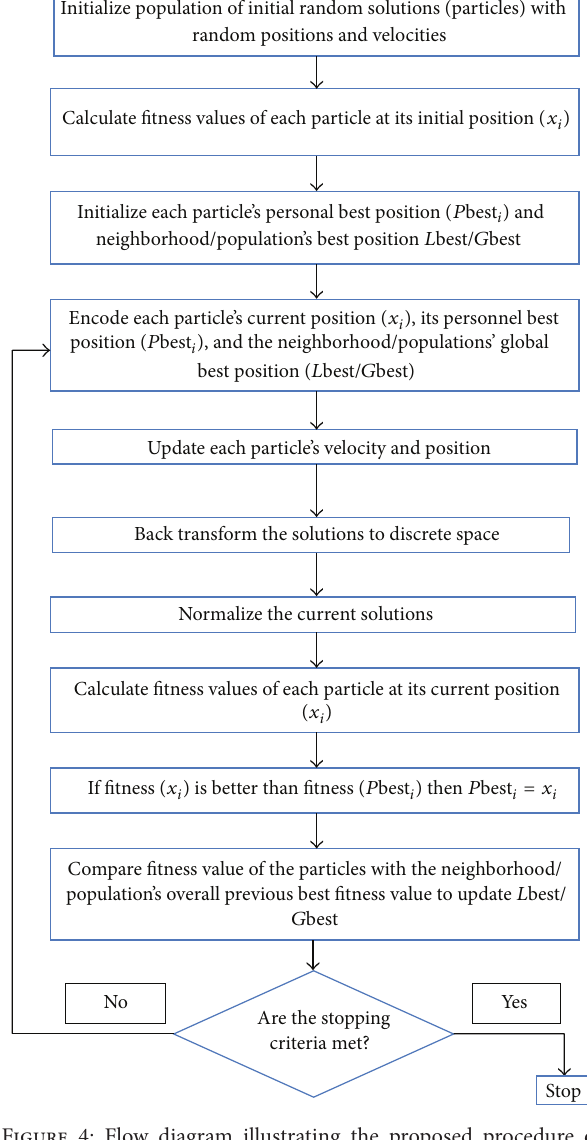
Figure 4: Flow diagram illustrating the proposed procedure of applying PSO algorithm (with the modifications) to the open pit mine production scheduling